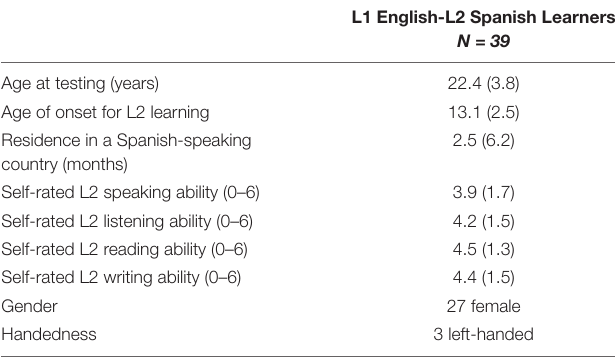
TABLE 2 | Demographic information for participants.